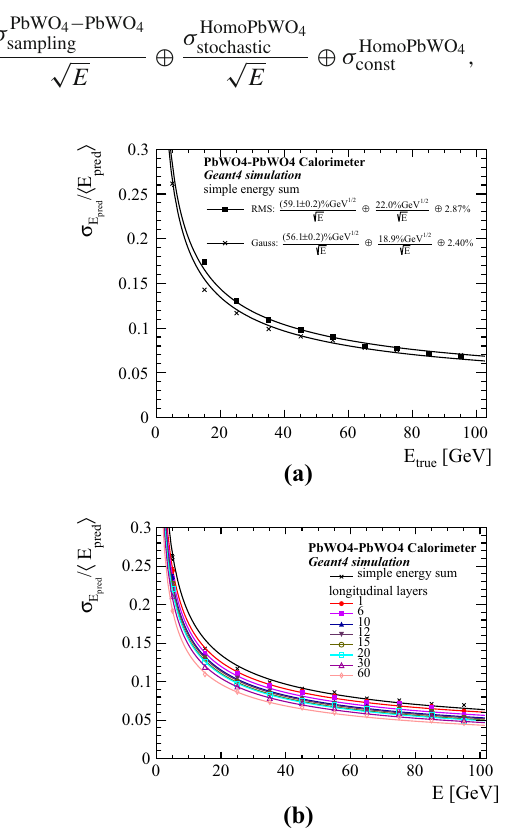
Fig. 8 EnergyresolutionofthePbWO 4 –PbWO 4 samplingcalorimeter with an absorber fraction of 95%, observed from the simple energy sum in a and using the DNN with 1 up to 60 longitudinal layers in